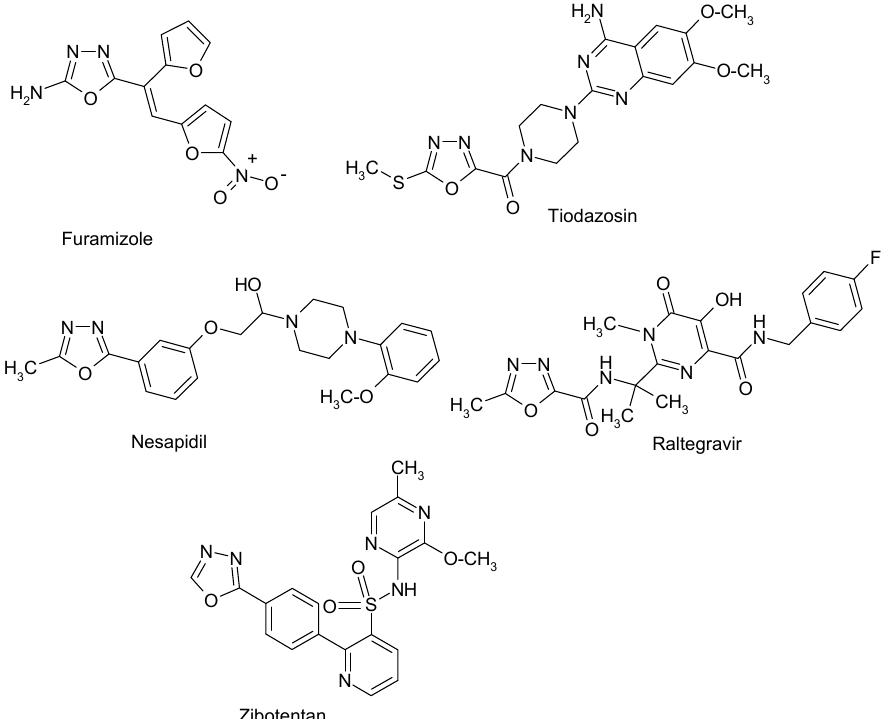
Figure 2. 1,3,4-Oxadiazole derivatives used as drugs.